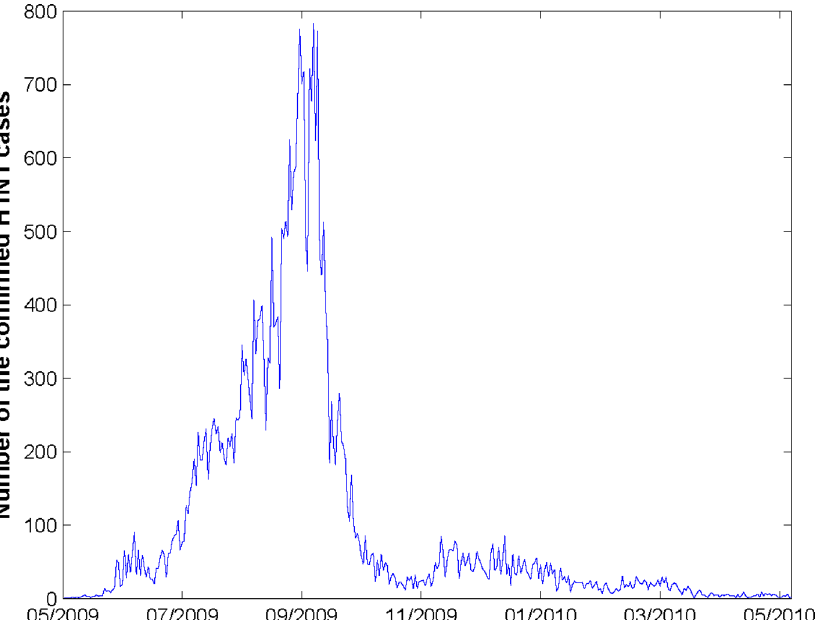
Figure 3. Daily H1N1 epidemic curve in Hong Kong from May 1, 2009 to May 23, 2010. The epidemic curve of confirmed H1N1 cases reaches its peak at the end of September,